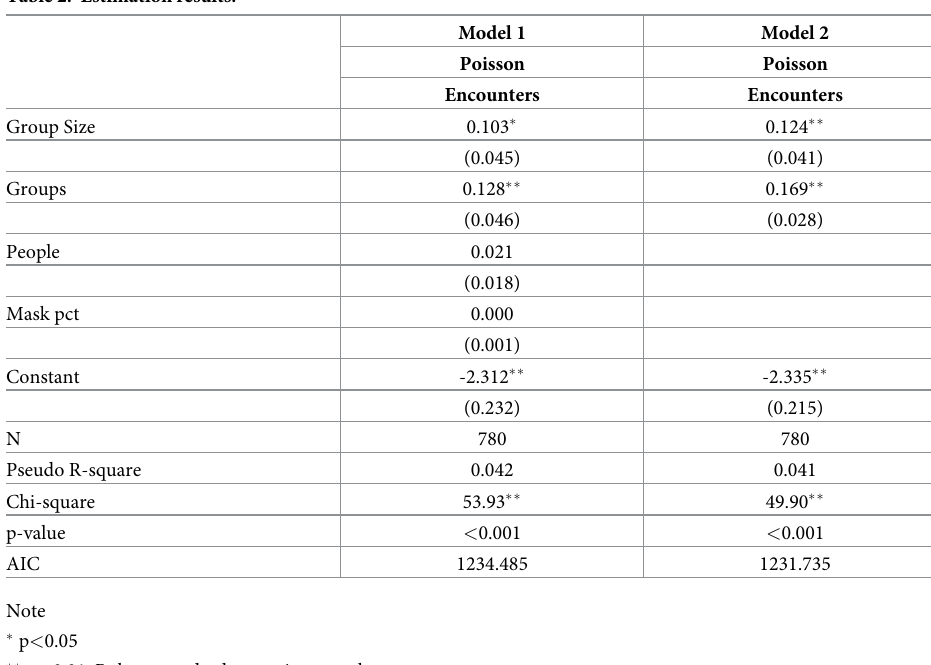
Table 2. Estimation